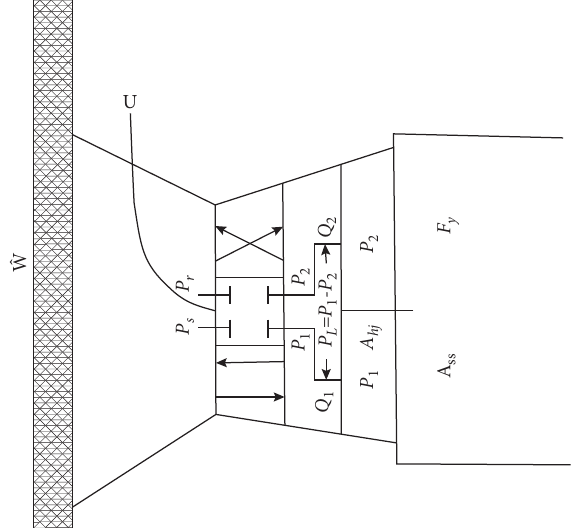
Figure 3: Schematic diagram of the servo system hydraulic jack pressed between the retaining wall and the end of steel bracing